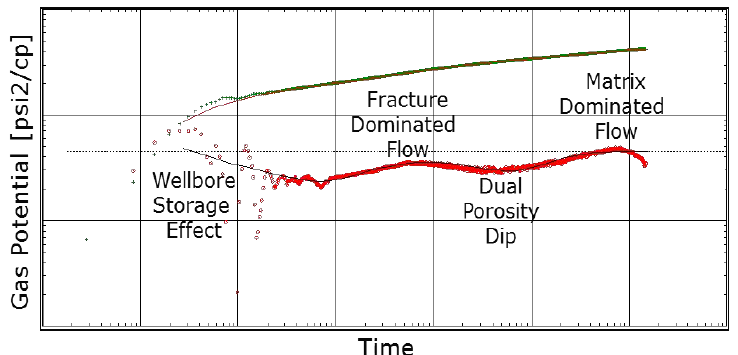
Figure 8—Well B dual porosity model as interpreted from